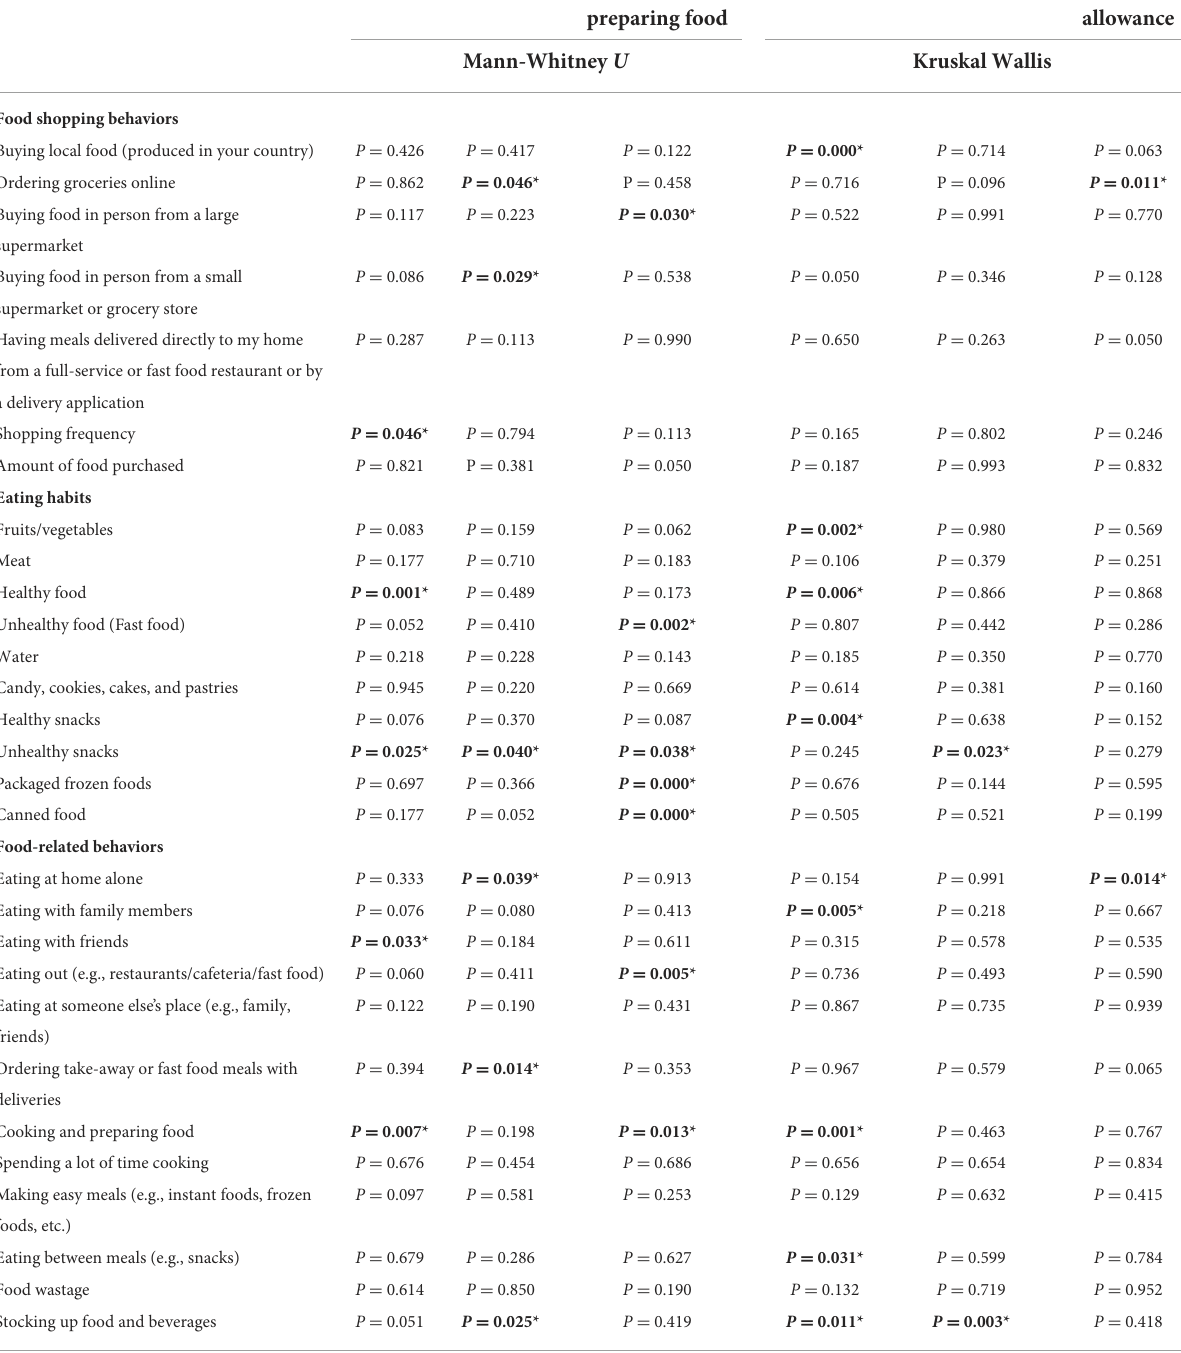
TABLE 3 Socio-demographic effects on food behavior and consumption habits after the availability of the COVID-19 vaccine. Gender University Preparing/help in Living status Field of study Monthly preparing food allowance Mann-Whitney